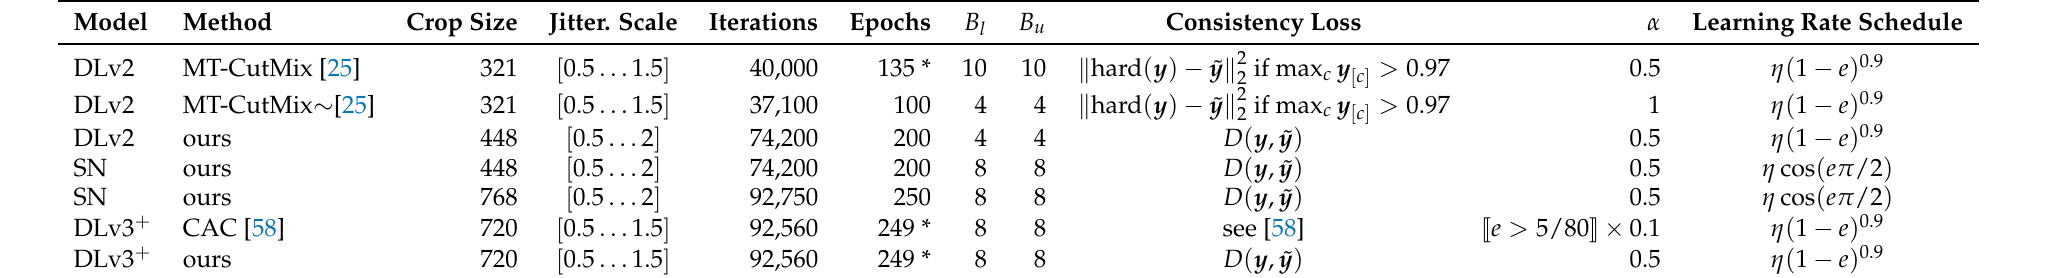
Table A1. Overview of hyper-parameters of consistency-based algorithms for semi-supervised semantic segmentation. We denote the setup that we use in our experiments including supervised training with “our”. We use the following symbols: y is the teacher prediction, ˜ y is the student prediction, hard is a function that maps a vector representing a distribution to the closest one-hot vector (hard [ c ] = (cid:114) c = argmax loss weight, and η is the base learning rate. The if-clause in the “Consistency loss” column represents confidence thresholding, i.e., determines whether the pixel is included in loss computation.